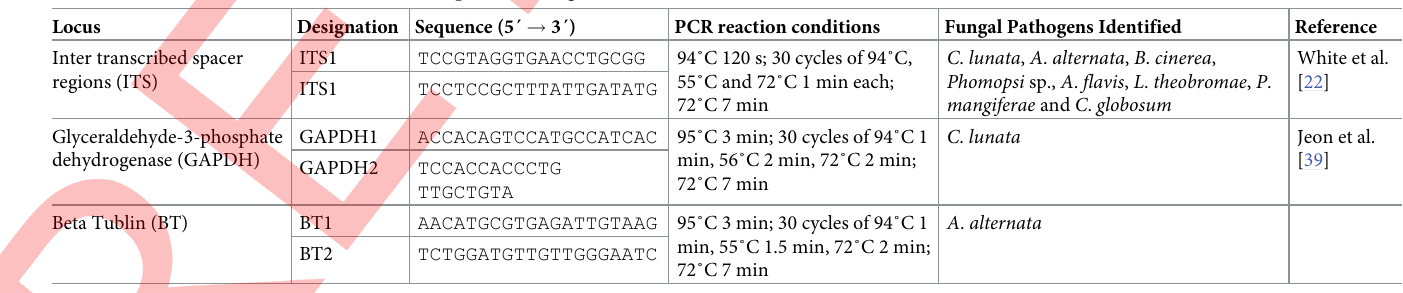
Table 2. PCR reaction and conditions for the amplification of gene